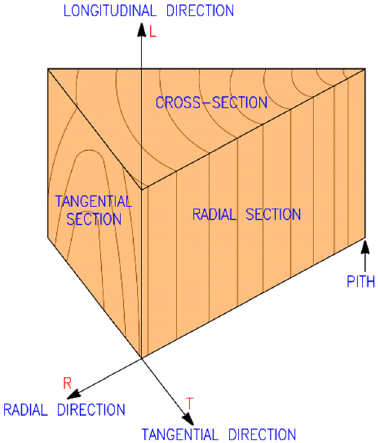
Figure 7. Definition of the orthotropic material for timber.